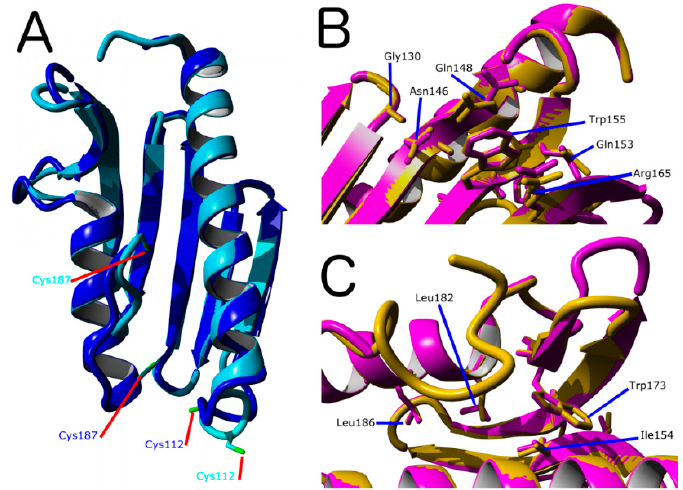
Figure 2. Molecular Model for of D. discoideum frataxin protein (DdFXN). ( A ) Structural alignment of models made using PDB IDs 1EKG (blue) and 6FCO (cyan) as templates. As a reference, residues Cys112 and Cys187 are shown. ( B ) Superimposition of the DdFXN model (magenta) and the human FXN variant (1EKG, orange) indicating the conserved residues among the variants involved in Friedreich’s Ataxia (FRDA), residues located in the β -sheet surface in human variant (Gly130, Gly137, Asn146, Gln148, Trp155, Arg165) and in DdFXN (Gly122, Asn137, Gln139, Trp146, and Arg156), and ( C ) residues located in the core of the protein in the human variant (Ile154, Trp173, Leu182 and Leu186) and in DdFXN (Ile145, Trp166, Leu175 and Leu179). Structural alignments were performed using Yasara. In addition, we included Gln153 (in the human variant) and Gln144 (in the DdFXN) given that mutation Q153A was reported to have a large effect on frataxin function [42].